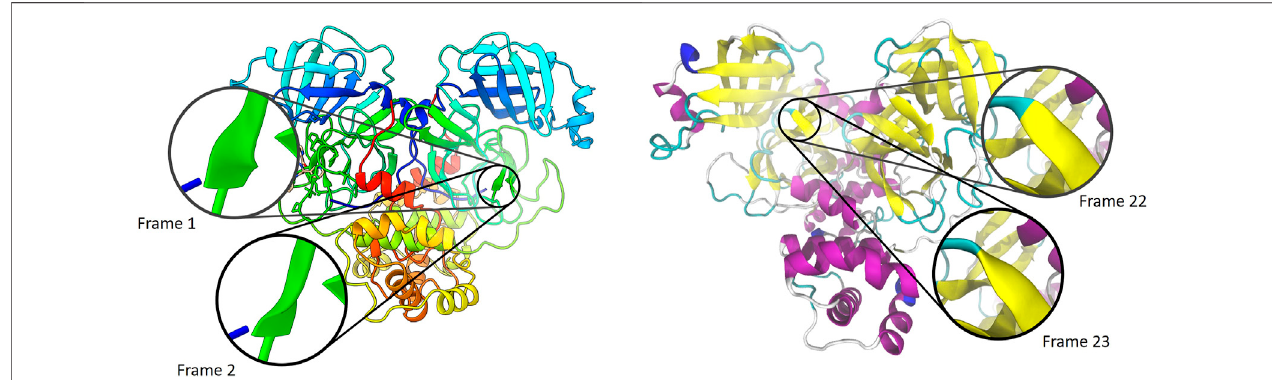
FIGURE 1 | Comparison of ribbon visualizations in ChimeraX 1.1 (left, Goddard et al. (2018)) and VMD 1.9.3 (right, Humphrey et al. (1996)) of the SARS-CoV-2 main protease (PDB ID 6W63). The trajectory from which these were taken was run within the Narupa framework (Jamieson-Binnie et al. (2020)), based upon input fi les used by Deeks et al. (2020). Each frame is separated by a timestep of 10